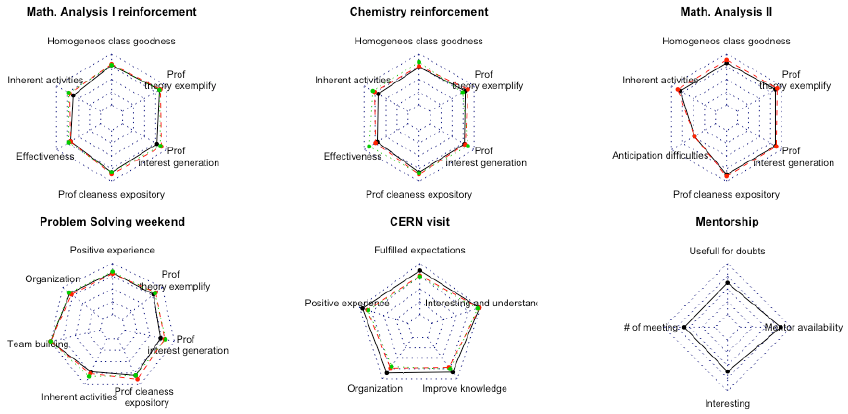
Fig. 7. Radar graph for each activity of the first year for the 3 cohorts